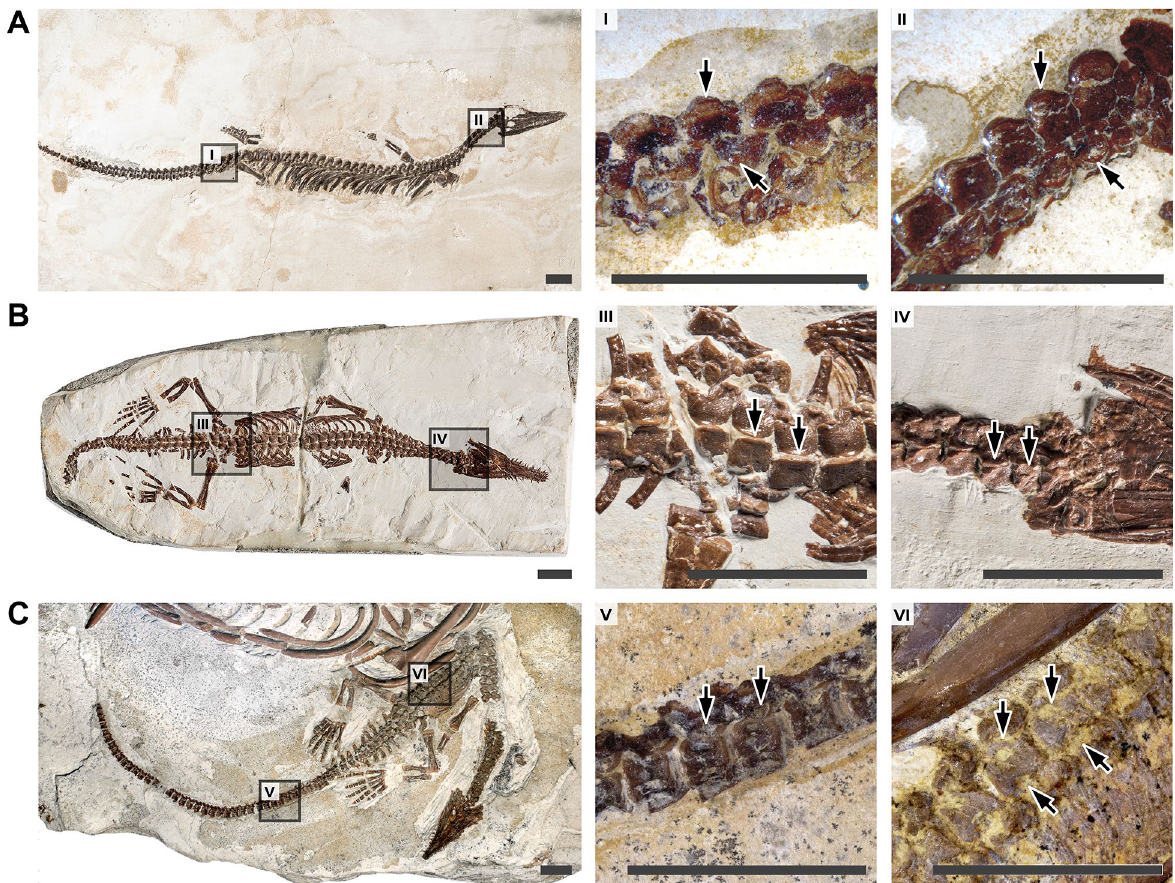
Figure 2. Juvenile specimens of Mesosaurus tenuidens showing axial ossification patterns. ( A ) SMF-R-4512, showing gradients of pleurocentrum and neural arch ossification; ( B ) BSPG 1979 I 37, showing a gradient of neural arch fusion; ( C ) MZSP-PV 1301, showing a gradient of neurocentral fusion. Specimens are oriented with the posterior region to the left and the anterior region to the right. Dark grey squares highlight the areas shown in close-up with the matching numbering. Arrows highlight differences in degree of ossification or fusion between two adjacent close-ups. Photographs ( A ) and ( B ) courtesy of ( C ). Radke (MfN). Photograph ( C ) courtesy of ( A ) Carvalho (MZSP). Scale bars: 10